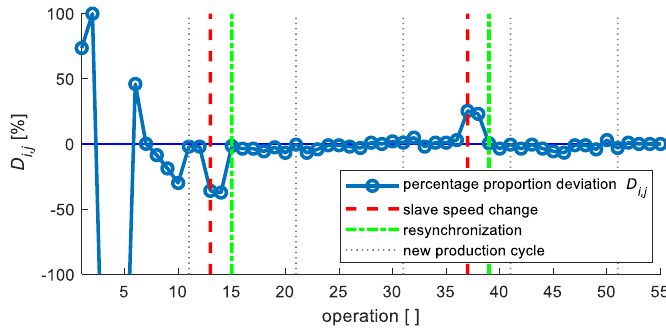
Figure 13. Operation duration times of master and slave manipulators with feedforward synchronization — Experiment 2b.